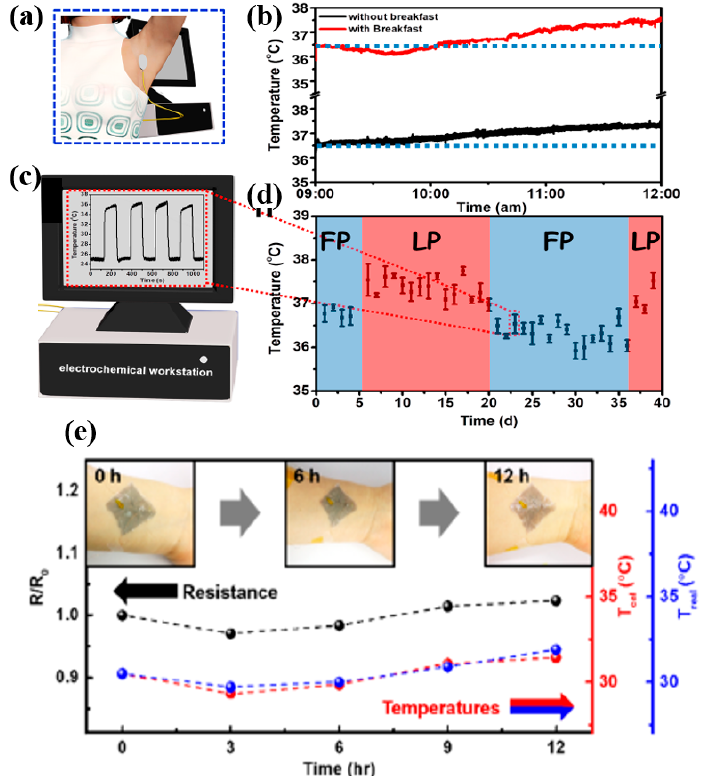
Figure 13. ( a ) Schematic of skin-mounted temperature sensor; ( b ) temperature curves with and without breakfast; ( c ) on–off cycles of the thermal response between in vitro body temperature and room temperature; ( d ) real-time monitoring of in vitro body temperature of a volunteer without breakfast (black) or with breakfast (red). Temperature measurement was of a female volunteer at 5 pm every day. The follicular phase (FP) and luteal phase (LP) tested according to the temperature variation are clarified by blue and red regions [46] (reproduced with permission). ( e ) Changes in the relative resistance (left y -axis), measured every 3h during a 12-h attachment onto an arm. The red and blue data correspond to the temperatures estimated from the relative resistance change of our device and that measured by an infrared (IR) thermometer (right y -axis) [131] (reproduced with permission).